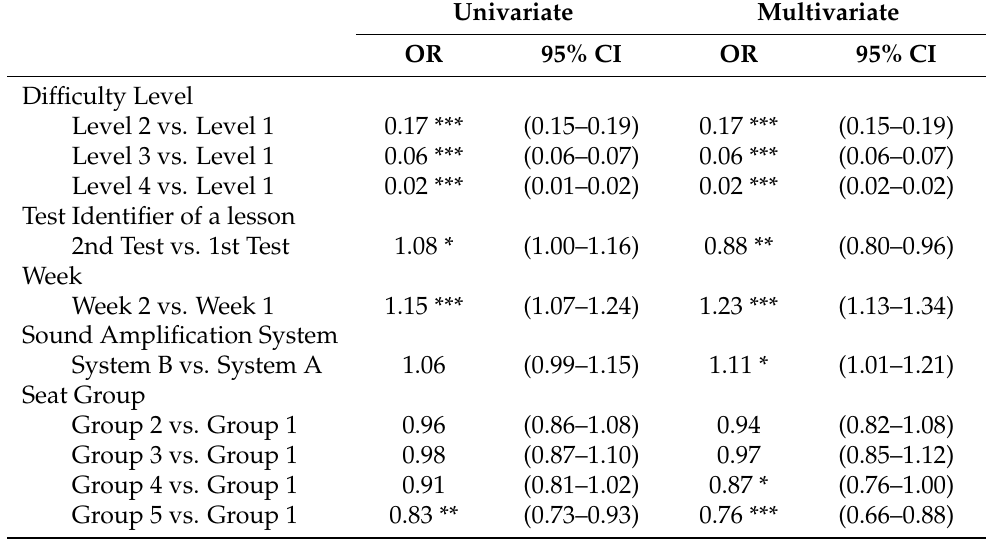
Table 6. Logistic regression for all data.